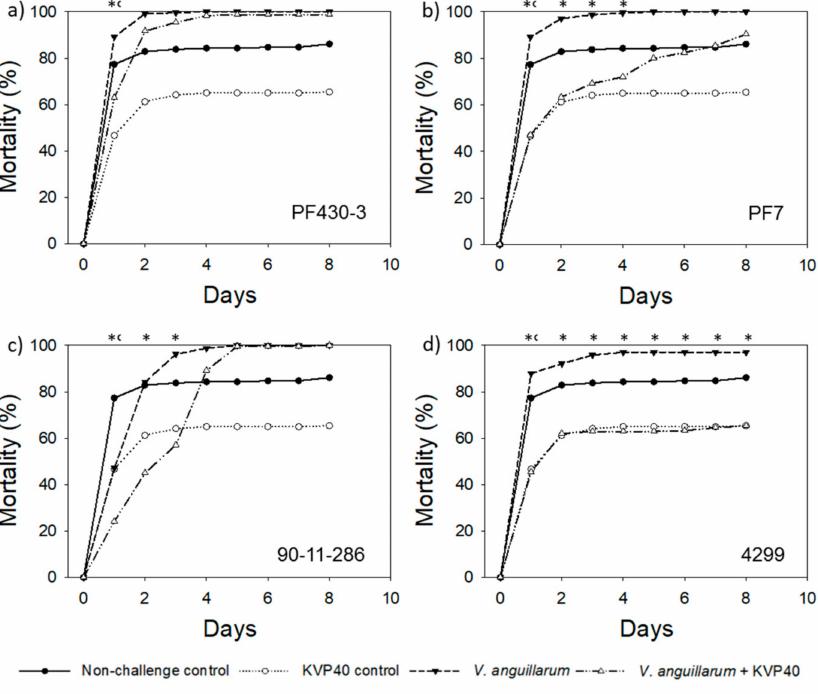
Figure 1. Cumulative percent mortality over time in turbot challenge trial 1: ( a ) strain PF430-3; ( b ) strain PF7; ( c ) strain 90-11-286; ( d ) strain 4299. Significant difference in mortality between cultures “ V. anguillarum ” and “ V. anguillarum + KVP40” for individual time points is indicated by *. Significant difference in mortality between cultures “Nonchallenge control” and “KVP40 control” is indicated by c